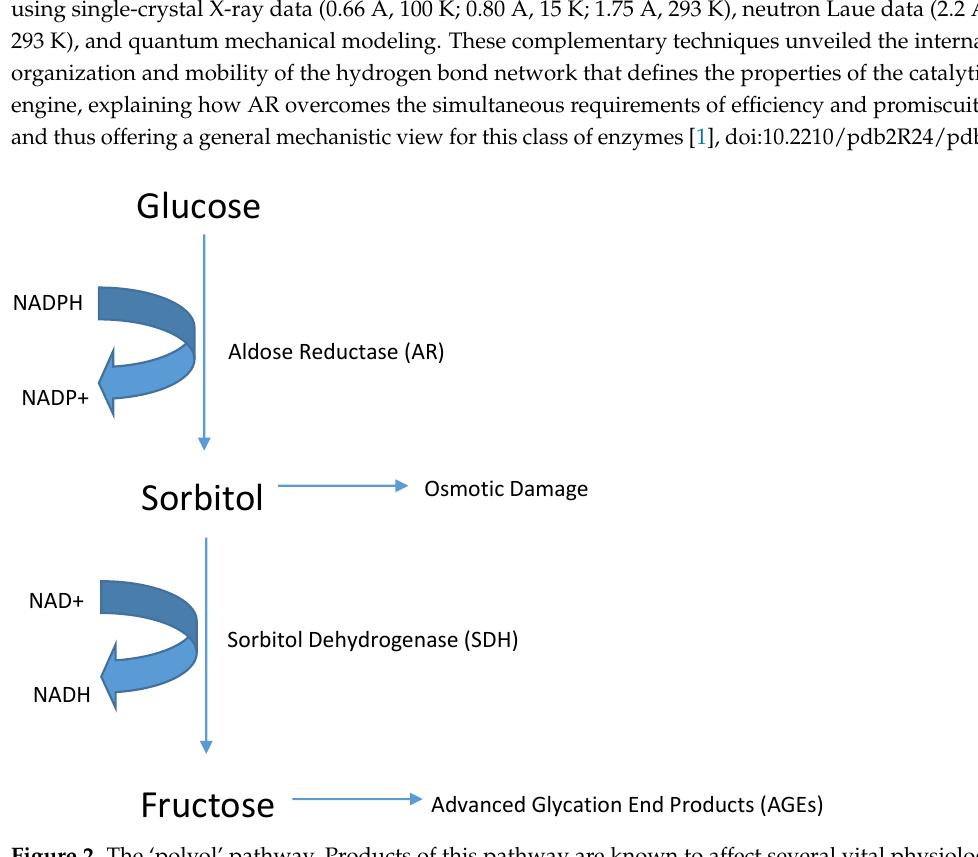
Figure 2. The ‘polyol’ pathway. Products of this pathway are known to affect several vital physiolog- ical functions of the cell in the